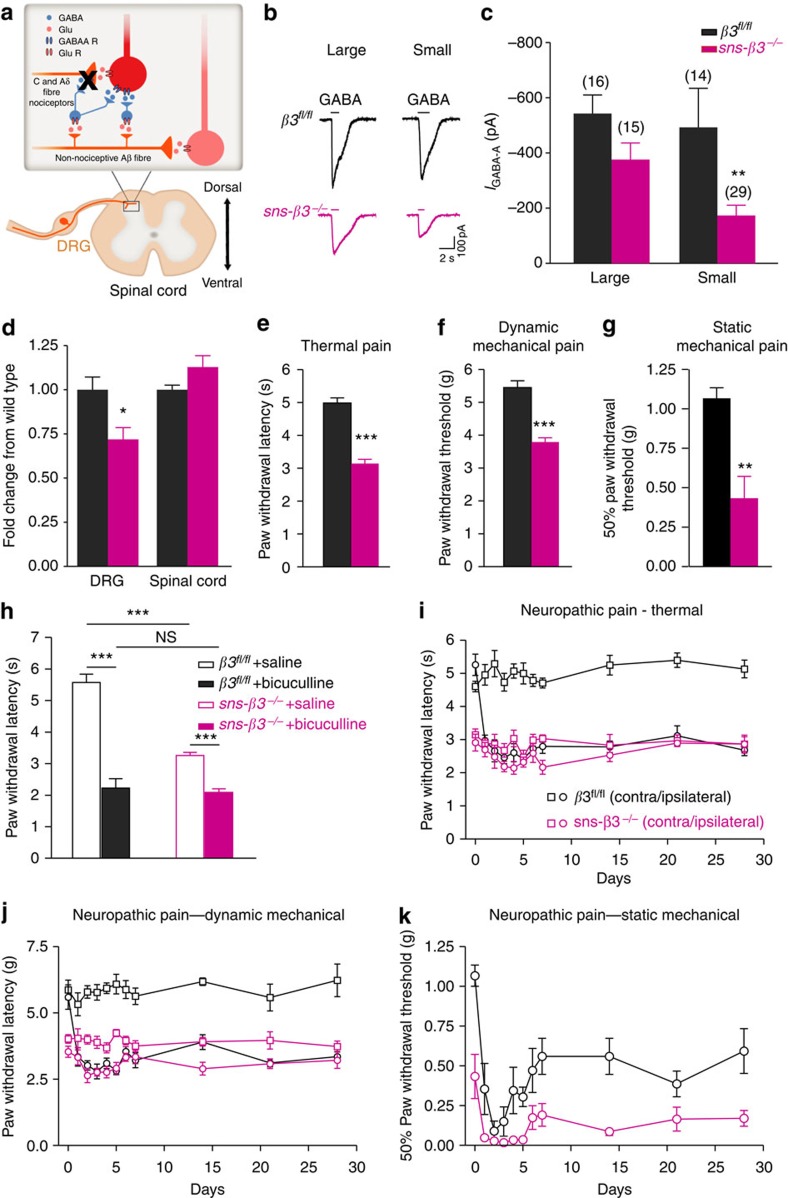
Pain behaviour in nociceptor-specific presynaptic GABAAR knockout (KO) mice and littermate controls.(a) Scheme illustrating the specific KO of GABAAR in nociceptors. (b) Representative traces of GABA-activated currents recorded in large (left) and small (right) DRG neurons clamped at −60 mV from β3fl/fl and sns- β3−/− mice. (c) Statistical analysis shows the amplitude of GABA-activated current is significantly reduced in small but not in large DRG neurons from sns- β3−/− mice compared with β3fl/fl mice; large neuron: P>0.05; small neuron: P<0.01, unpaired t-test. (d) Quantification of gabaβ3 gene transcripts in the DRGs and spinal cord of sns- β3−/− and their WT littermates. DRG: P<0.05; spinal cord: P>0.05; n=9 for each. (e) Hargreaves: sns- β3−/− mice exhibit higher sensitivity to noxious heat stimulation (β3fl/fl: n=12; sns- β3−/−: n=12. P<0.0001). (f) Dynamic Plantar Aesthesiometer: sns- β3−/− mice show increased sensitivity to noxious mechanical stimulation (β3fl/fl: n=12; sns- β3−/−: n=12. P<0.0001). (g) Von Frey: mechanical threshold were measured using Von Frey hairs (β3fl/fl: n=6; sns- β3−/−: n=6. P<0.01). (h) Bicuculline increased thermal sensitivity of both sns- β3−/− and their WT littermates. n=6 mice per group (β3fl/fl: saline versus bicuculline, P<0.0001; sns- β3−/−: saline versus bicuculline, P<0.0001; saline: β3fl/fl versus sns- β3−/−, P<0.0001; bicuculline: β3fl/fl versus sns- β3−/−, P>0.05). (i) sns- β3−/− mice failed to develop thermal hypersensitivity after CCI. n=6 mice per group. (Two-way analysis of variance (ANOVA): β3fl/fl contralateral versus ipsilateral, P<0.0001; sns- β3−/− contralateral versus ipsilateral, P=0.0457; β3fl/fl ipsilateral versus sns- β3−/− ipsilateral after injury, P>0.05). (j) Dynamic mechanical hypersensitivity is significantly reduced in sns- β3−/− mice. n=6 mice per group. (Two-way ANOVA: β3fl/fl contralateral versus ipsilateral, P<0.0001; sns- β3−/− contralateral versus ipsilateral, P=0.0004; β3fl/fl ipsilateral versus sns- β3−/− ipsilateral after injury, P>0.05). (k) Static mechanical allodynia is not affected in sns- β3−/− mice. n=6 mice per group (Two-way ANOVA, P<0.0001). Error bars indicate s.e.m. *P<0.05; **P<0.01; ***P<0.0001.